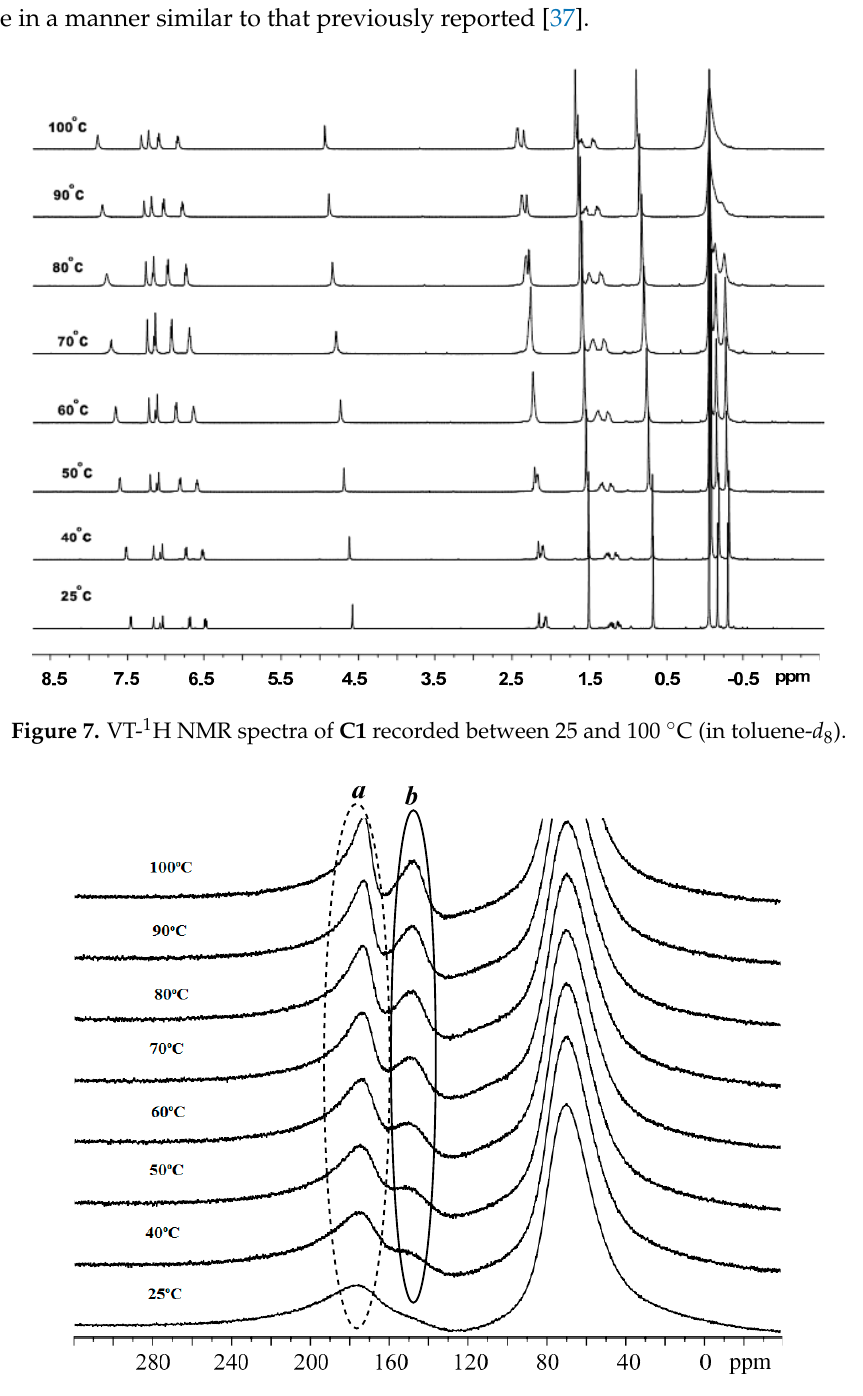
Figure 8. VT- 27 Al NMR spectra of C1 recorded between 25 and 100 °C (in toluene- d 8 ); the broad signal at δ 68.0 derives from the aluminum alloy present in the NMR probe.